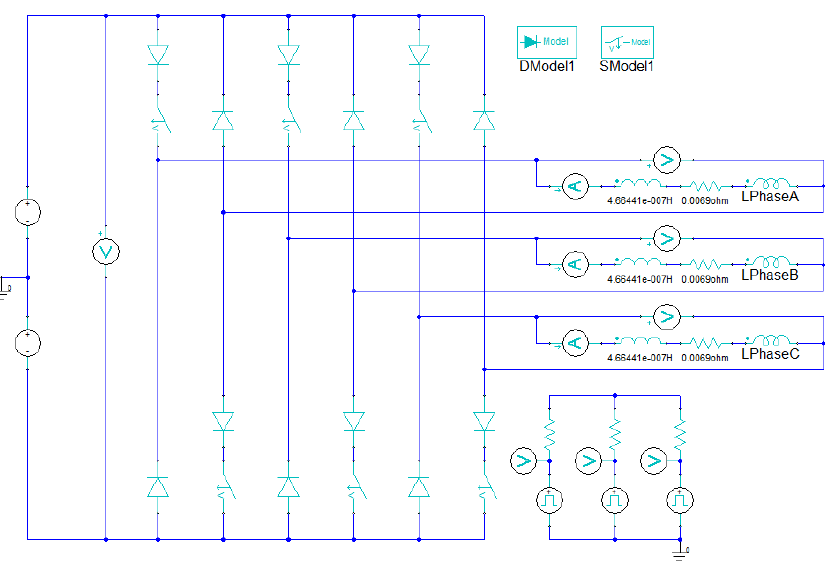
Figure 12. Simulation driving circuit for the two motors.